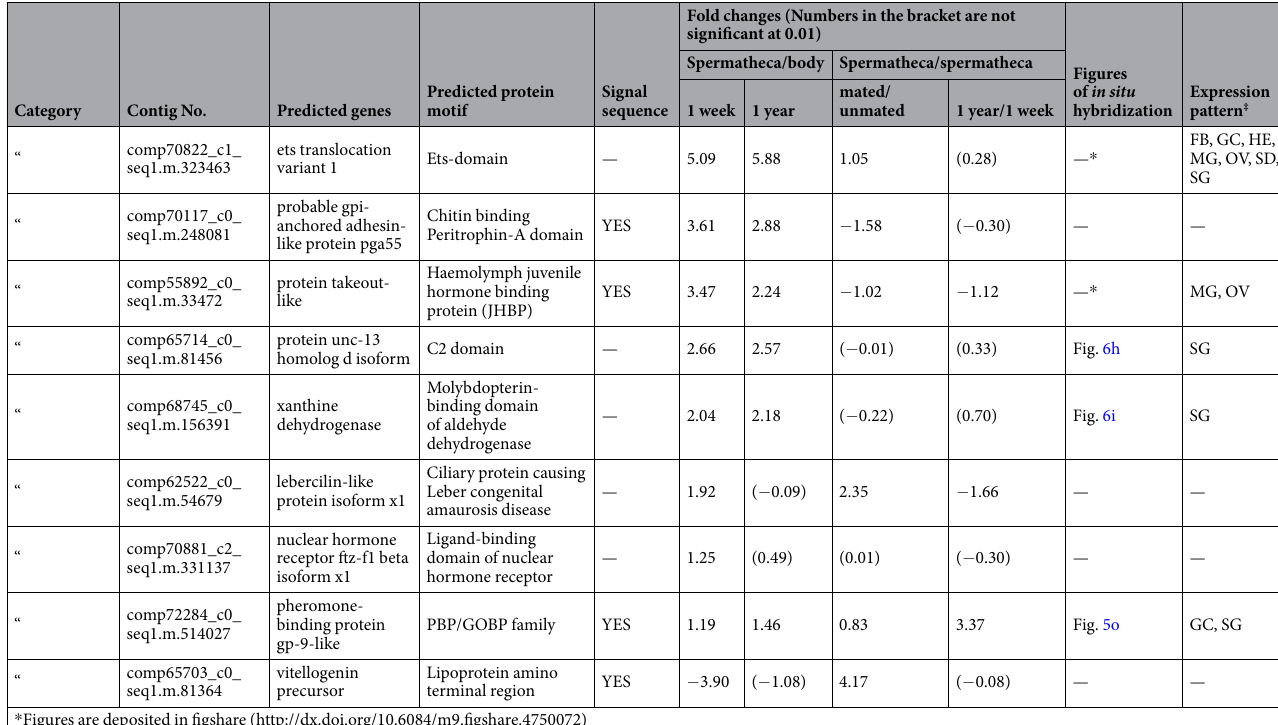
Table 1. List of selected genes expressed in the spermatheca. ‡ Failed = no signals, GC = genital chamber, SG = spermathecal gland, HE = hilar columnar epithelial cells of spermatheca reservoir, SD = spermathecal duct, OV = ovary, MG = midgut, CO = common